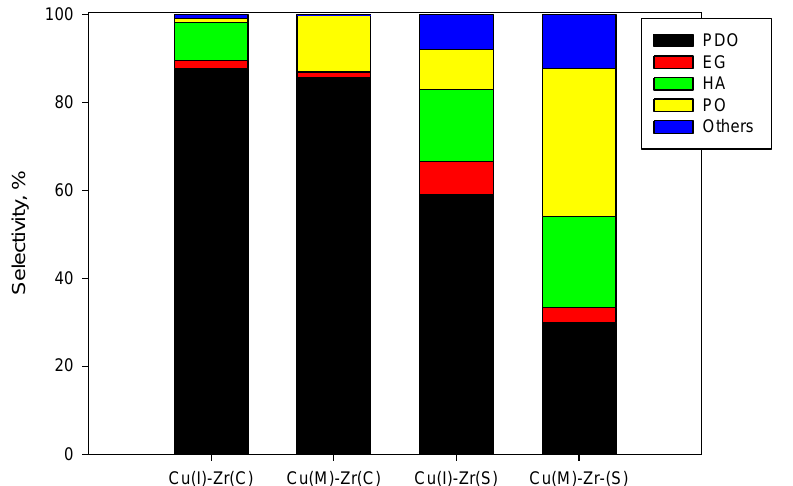
Figure 7. Selectivities to products for the different catalysts. T = 240 °C; initial P = 20 bar(g); H 2 = 20 vol%; reaction time = 24 h; rotation speed = 500 rpm. (PDO = 1,2-propanediol, EG = ethylene glycol, HA = hydroxyacetone, PO = 1-propanol).